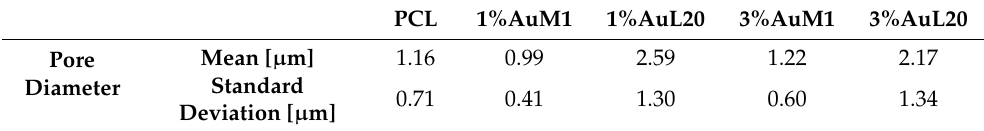
Figure 9. Fiber diameter distribution of: ( a ) PCL; ( b ) 1%AuM1; ( c ) 1%AuL20; ( d ) 3%AuL20; ( e ) 3%AuM1. Table 3. Pore size distribution parameters.